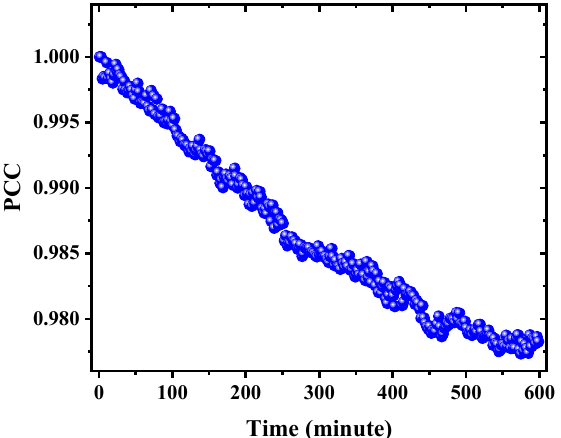
Figure 9. Stability test results of the sensing system.